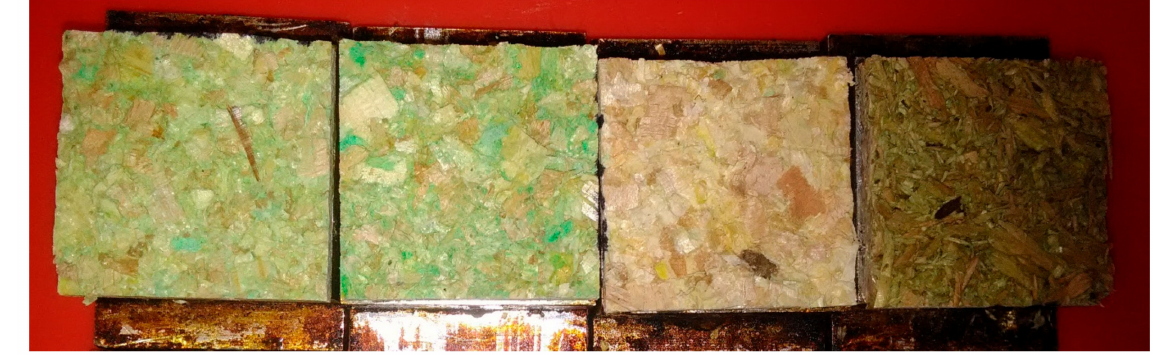
Figure 3. Green discoloration by added pigments on broken IB samples from left to right: C12S_M, C12P_M, C12S_D, and